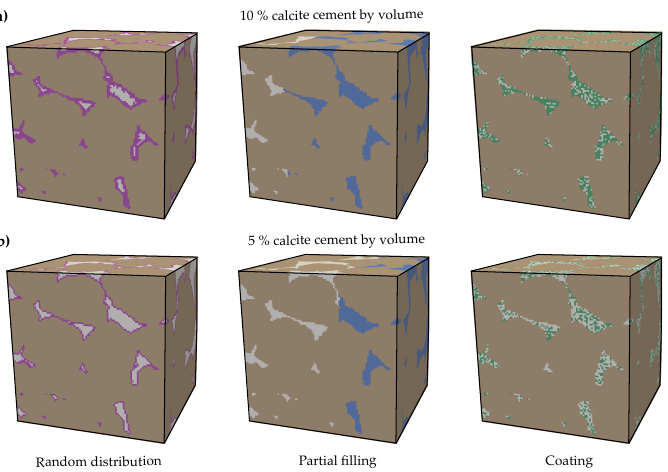
Figure 6. Representative sub-cubes of the Fontainebleau sandstone comprise quartz grains (brown), pore space (light grey) and calcite cement with three general spatial arrangements: random distribution (green), partial filling (blue) and coating (magenta). The pore network is exemplarily filled with a calcite cement volume fraction of ( a ) 10% and ( b )